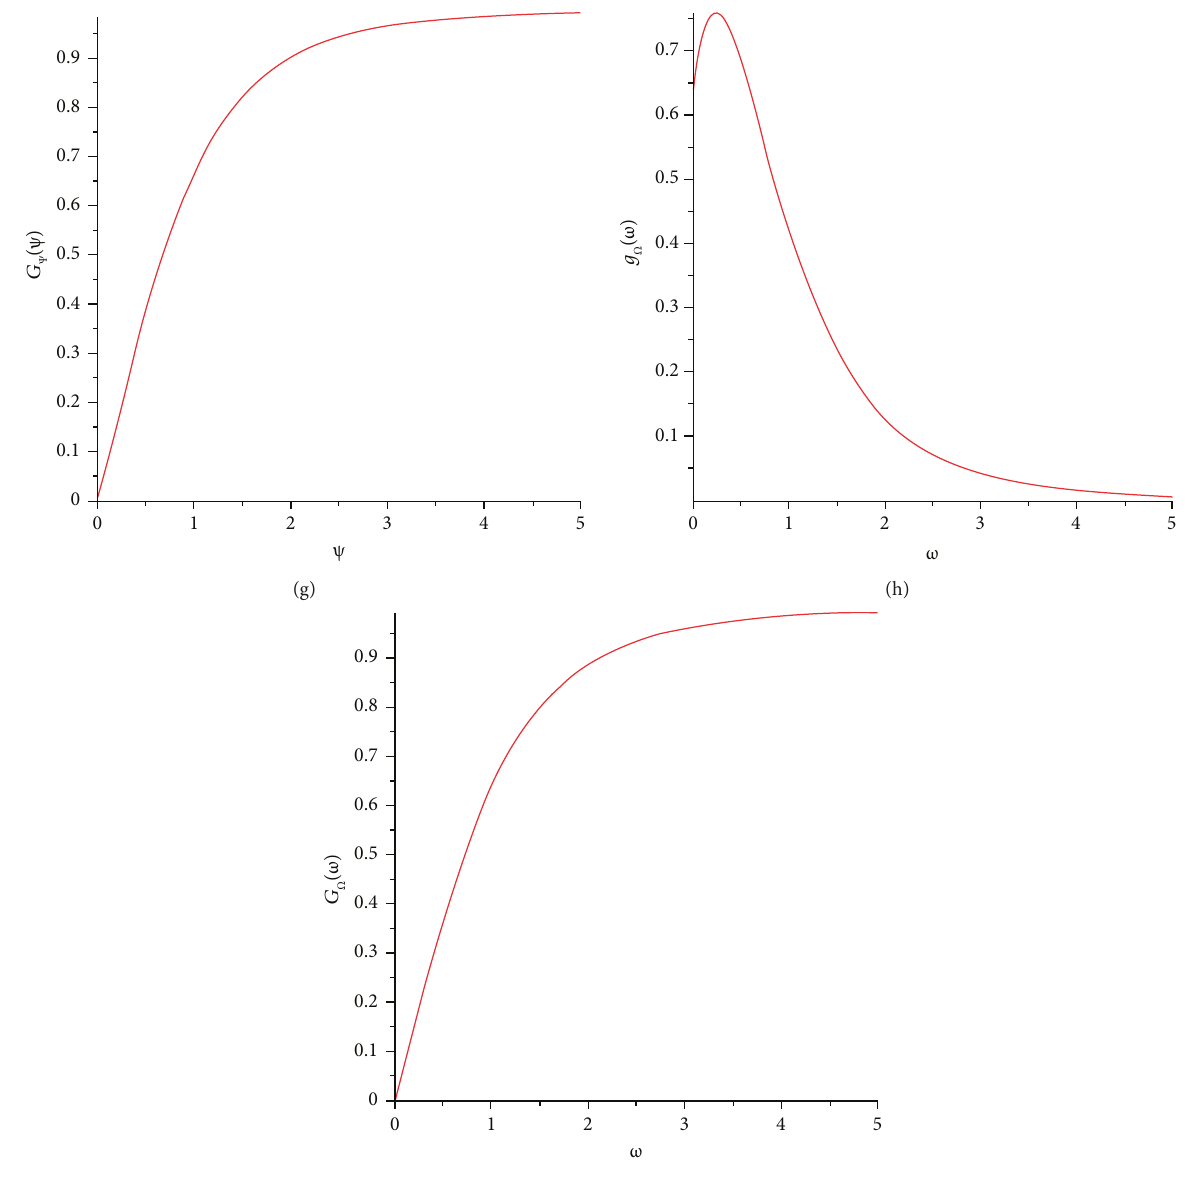
Figure 1: Statistical quantities for the set I of parameters, ( θ , ξ